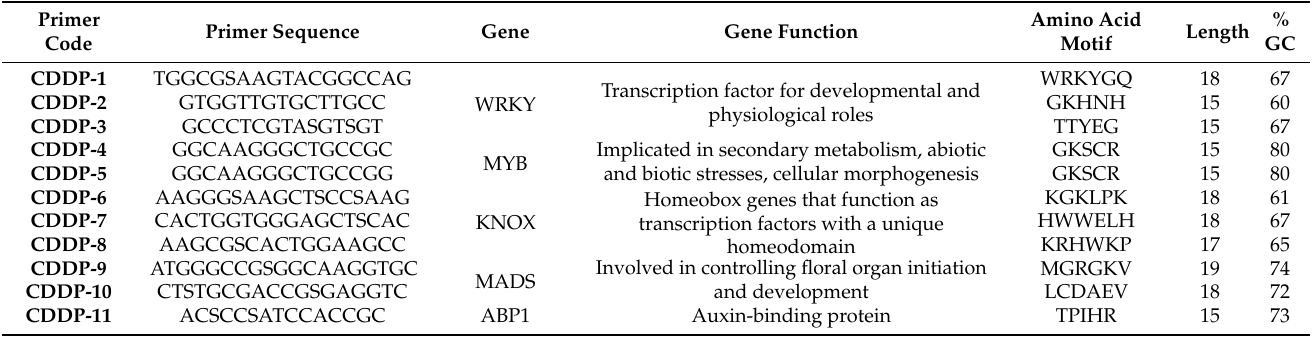
Table 1. CDDP Primers code, sequence, conserved targets, and details.